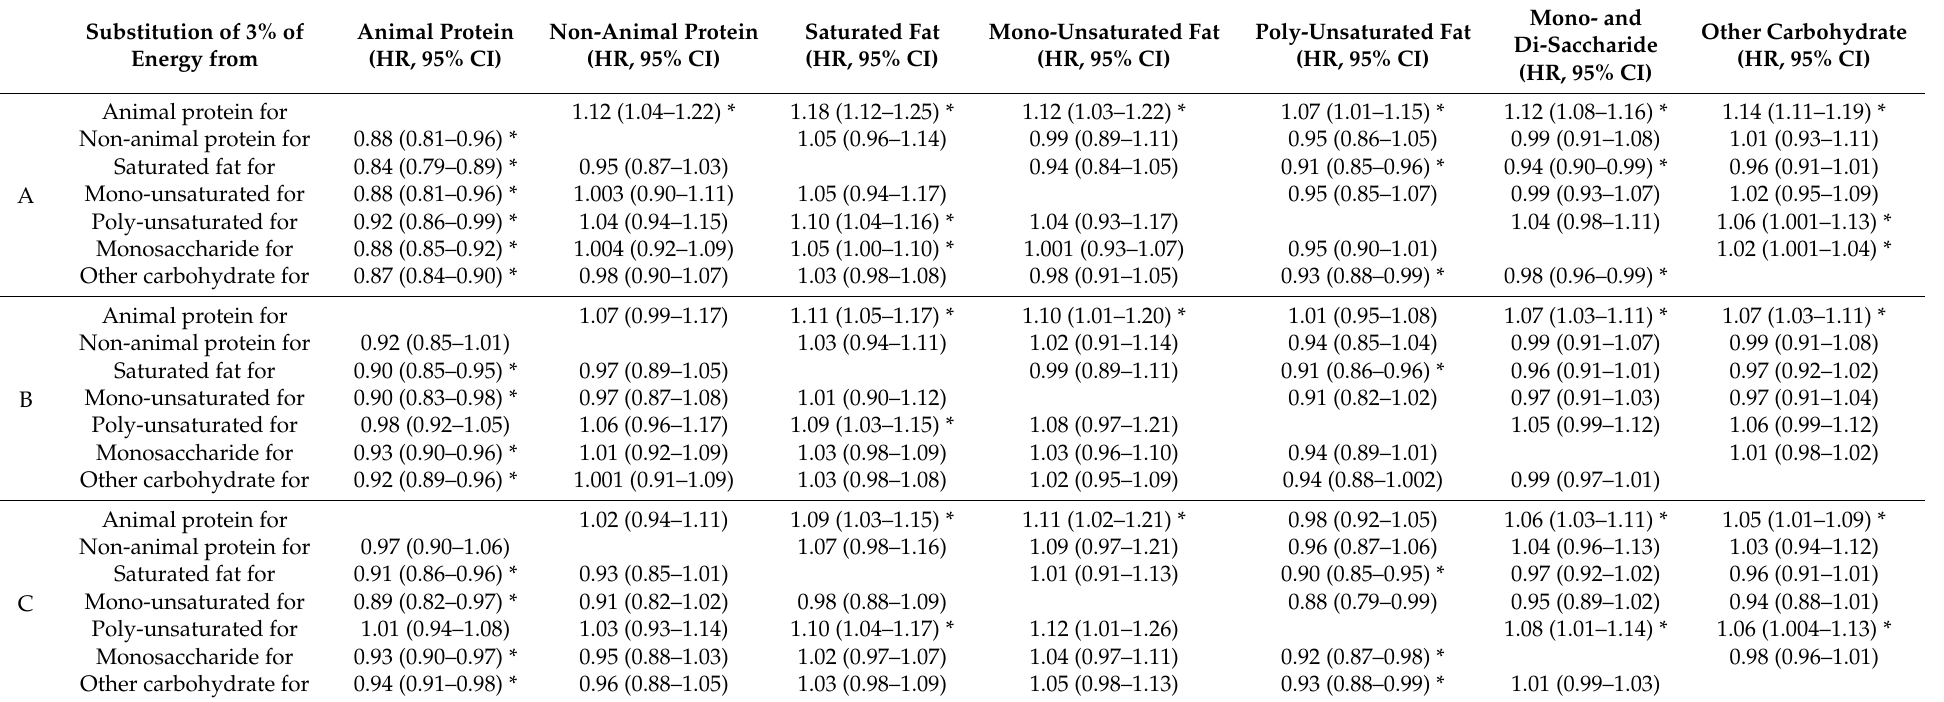
Table 2. Scenarios for the association of 3% substitution of energy among macronutrients with all-cause mortality ( n =